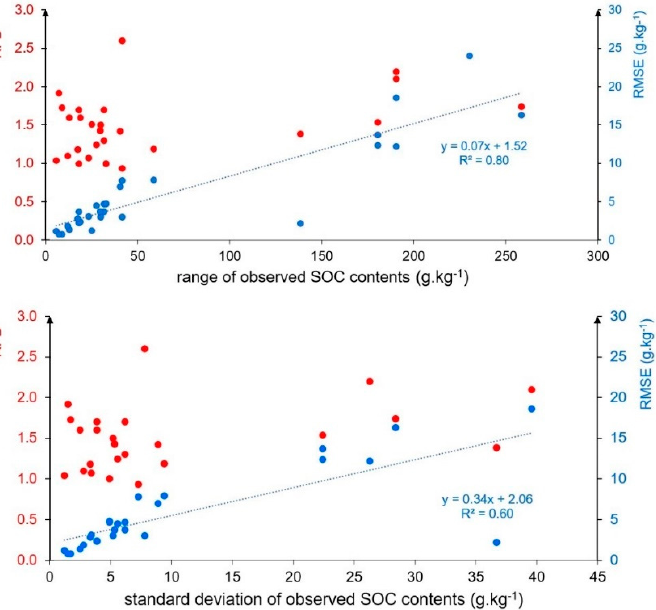
Figure 6. Plot of performance indicators versus range ( top ) or standard deviation ( bottom ) of measured SOC contents for all models [18,26,31,34,47–50,58,74,79–81]. The magnitude of error is the highest for national to continental scales, where it typ- ically reaches 15 g·kg − 1 or even more, exceeding the observed range of values for single fields or some small homogeneous regions. For a given range of measured SOC contents, the prediction results (e.g., RPD) may vary according to acquisition and soil surface con- ditions over several dates [50,55,56]. Hence, the temporal variation adds up to the spatial